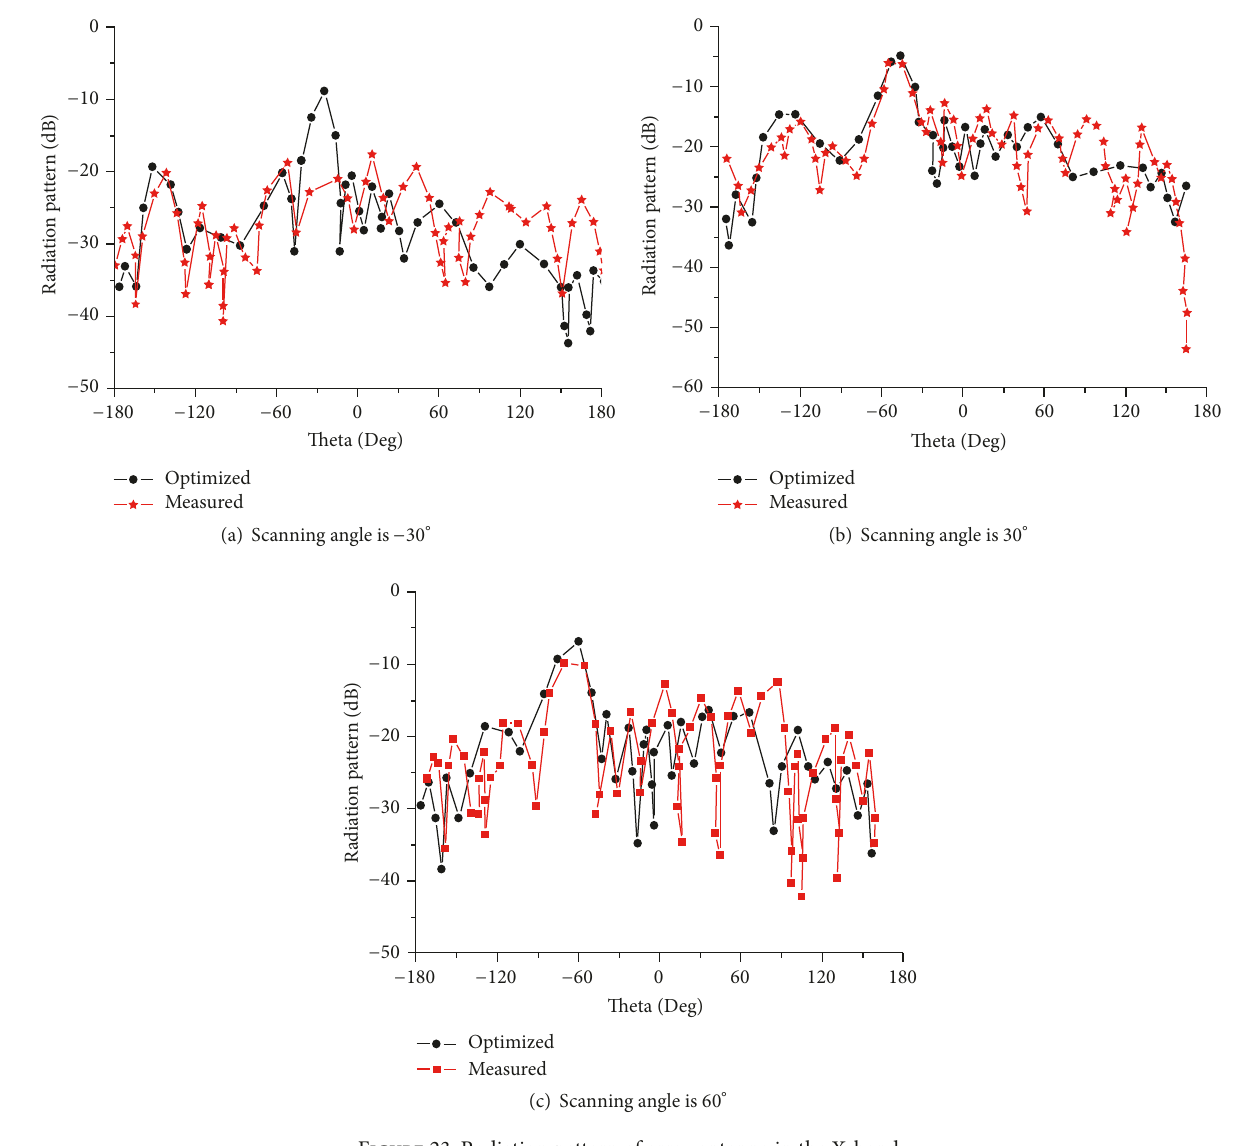
Figure 23: Radiation pattern of array antenna in the X-band.